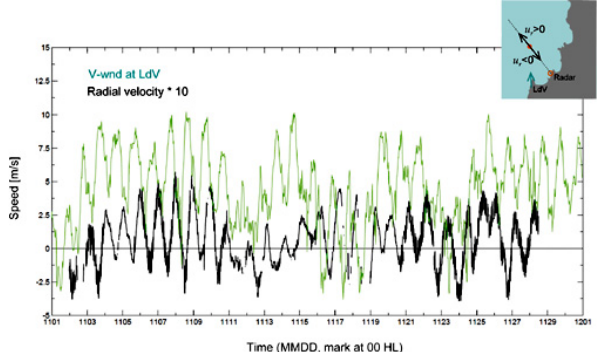
Fig. 14. Radial surface current at 30 ◦ S, 71.5 ◦ W (black line) mea- sured from the Tongoy HF Radar. Positive (negative) values away from (toward) the radar (see inset). Also shown is the meridional wind speed at point Lengua de Vaca (green line).